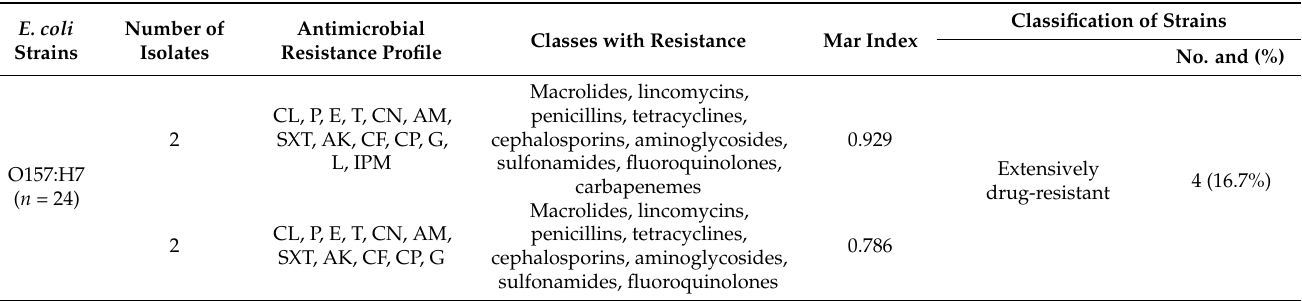
Table 3. Classification of E. coli O157:H7 and O55:H7 ( n = 126) based on their antimicrobial resistance degree against 14 antimicrobials